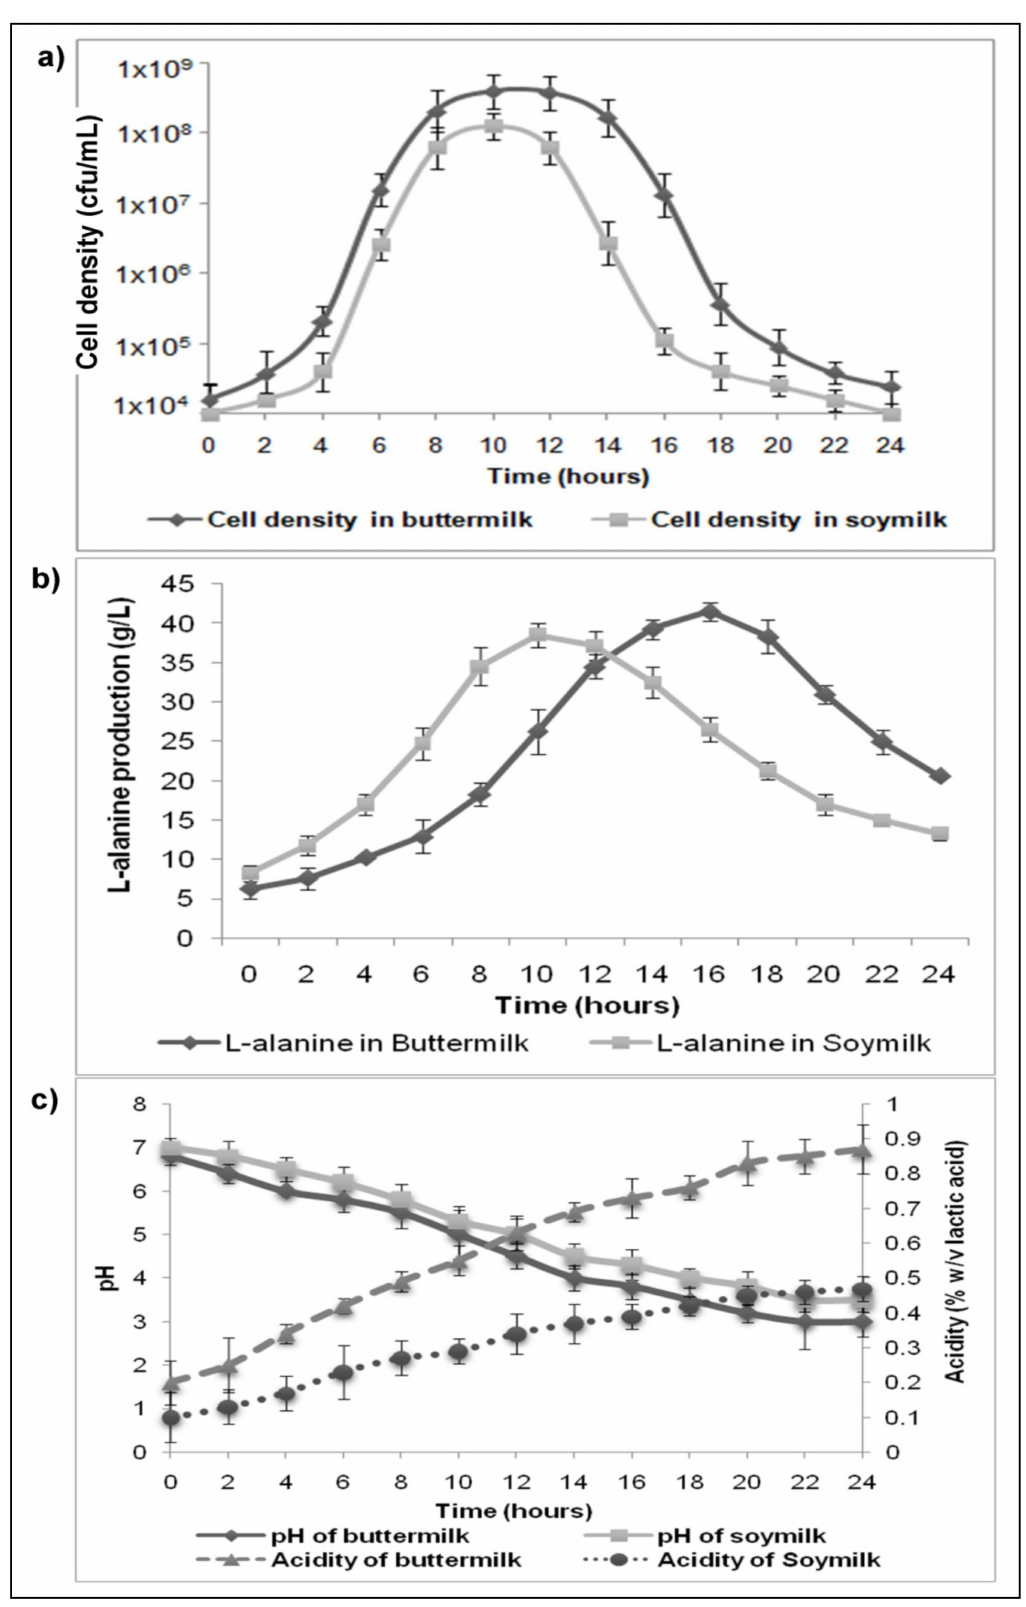
Figure 1. ( a ) Curves showing variations in cell densities (cfu/mL), ( b ) L-alanine production, and ( c ) pH vs. acidity in the buttermilk and soymilk during fermentation using P. acidilctici BD16 ( alaD + ). Values are presented as mean ± standard deviation (SD) of triplicate observations (n =